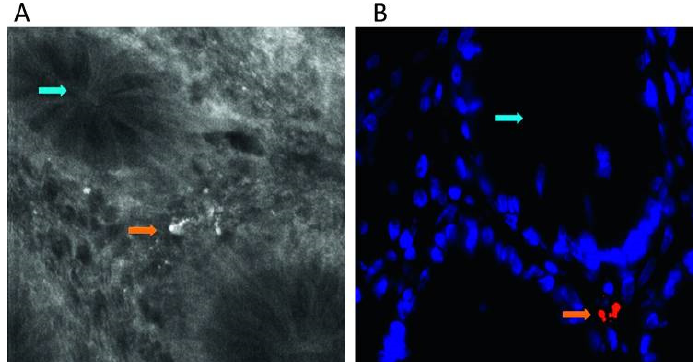
Figure 3. Intramucosal bacteria in human colon identified at confocal laser endomicroscopy and fluorescence in situ hybridization (FISH). ( A ) Fluorescent intramucosal bacteria within the lamina propria can readily be identified using fluorescein-aided endomicroscopy. Single crypts are shown with their characteristic round appearance (blue arrow). Single bacteria and clustered bacteria (orange arrow) can be identified within the lamina propria between two crypts (pericryptal space). ( B ) FISH testing confirmed the presence of intramucosal bacteria due to the bright red fluorescence. The nuclei and RNA are shown in blue. Reprinted with permission from [133]. Copyright © 2020, published by